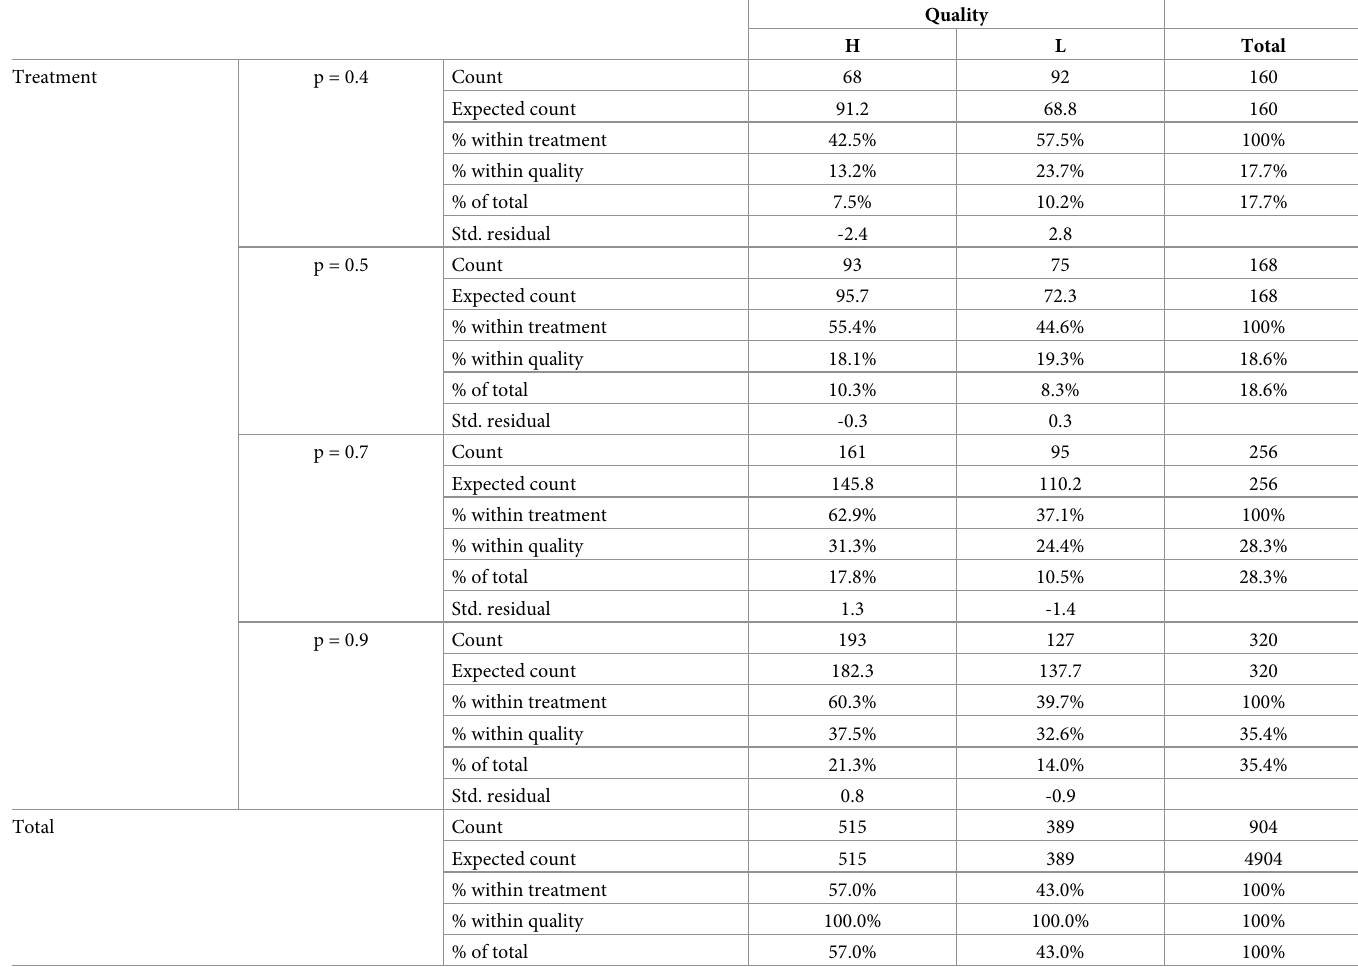
Table 4. Contingency table for chi-square test (SPSS output).